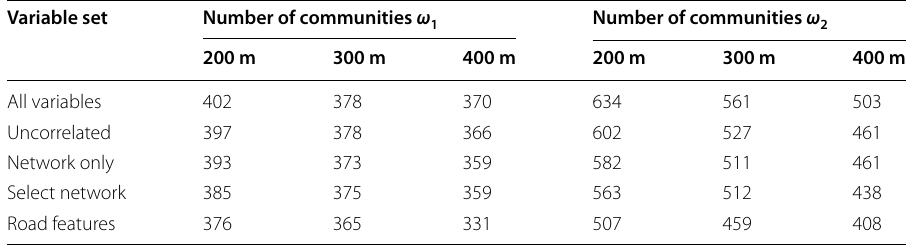
Table 4 Number of communities found for each parameter set Variable